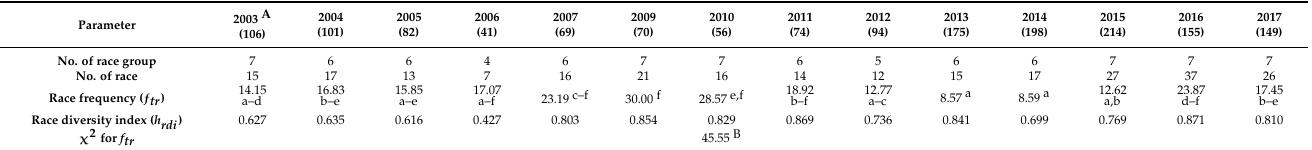
Table 1. Race diversity of 14 populations of P. oryzae in Jiangsu province from 2003 to 2017 tested with CDC